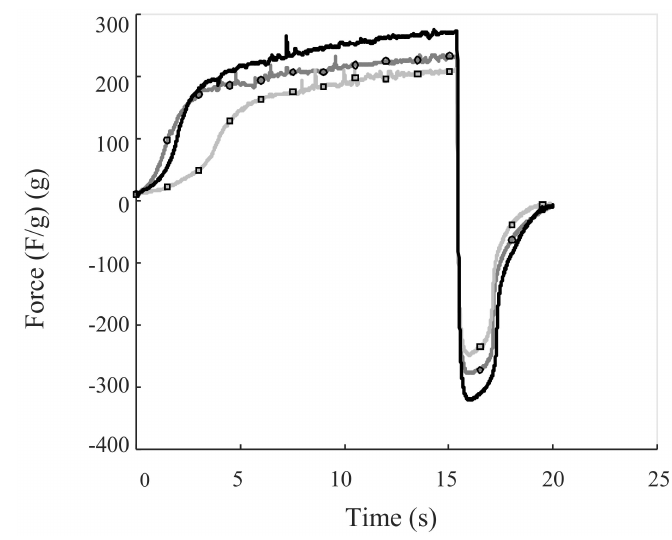
Figure 3. Graphs of back extrusion measurements. The black line represents the commercial reference mayonnaise, the gray line with circles the high emulsification intensity mayonnaise, and the gray line with squares the low emulsification intensity mayonnaise.